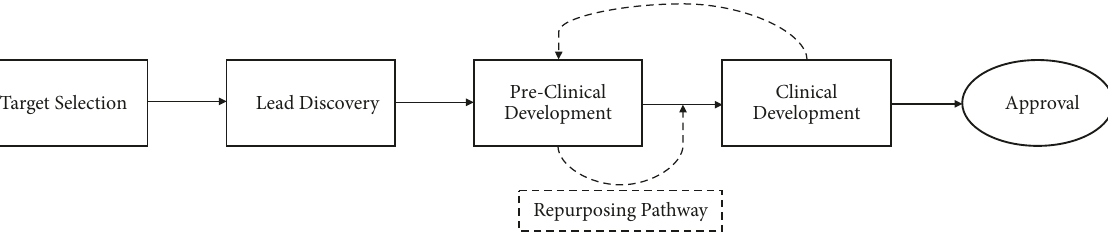
Figure 5: Scheme of a potential SMT development pathway. “Sections” correspond to paragraphs that follow. The repurposing pathway accelerates development and lowers costs by starting at a more advanced stage of development than a new chemical